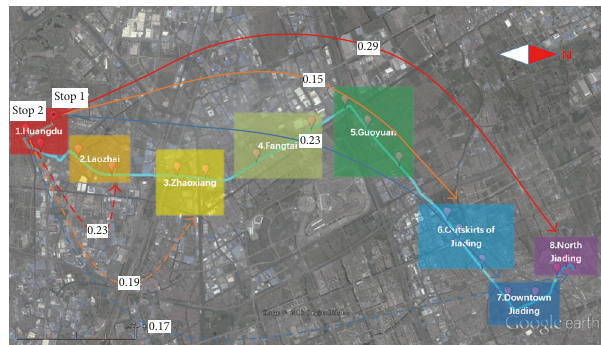
Figure 5: Top three alighting probabilities for boarding stops 1 and